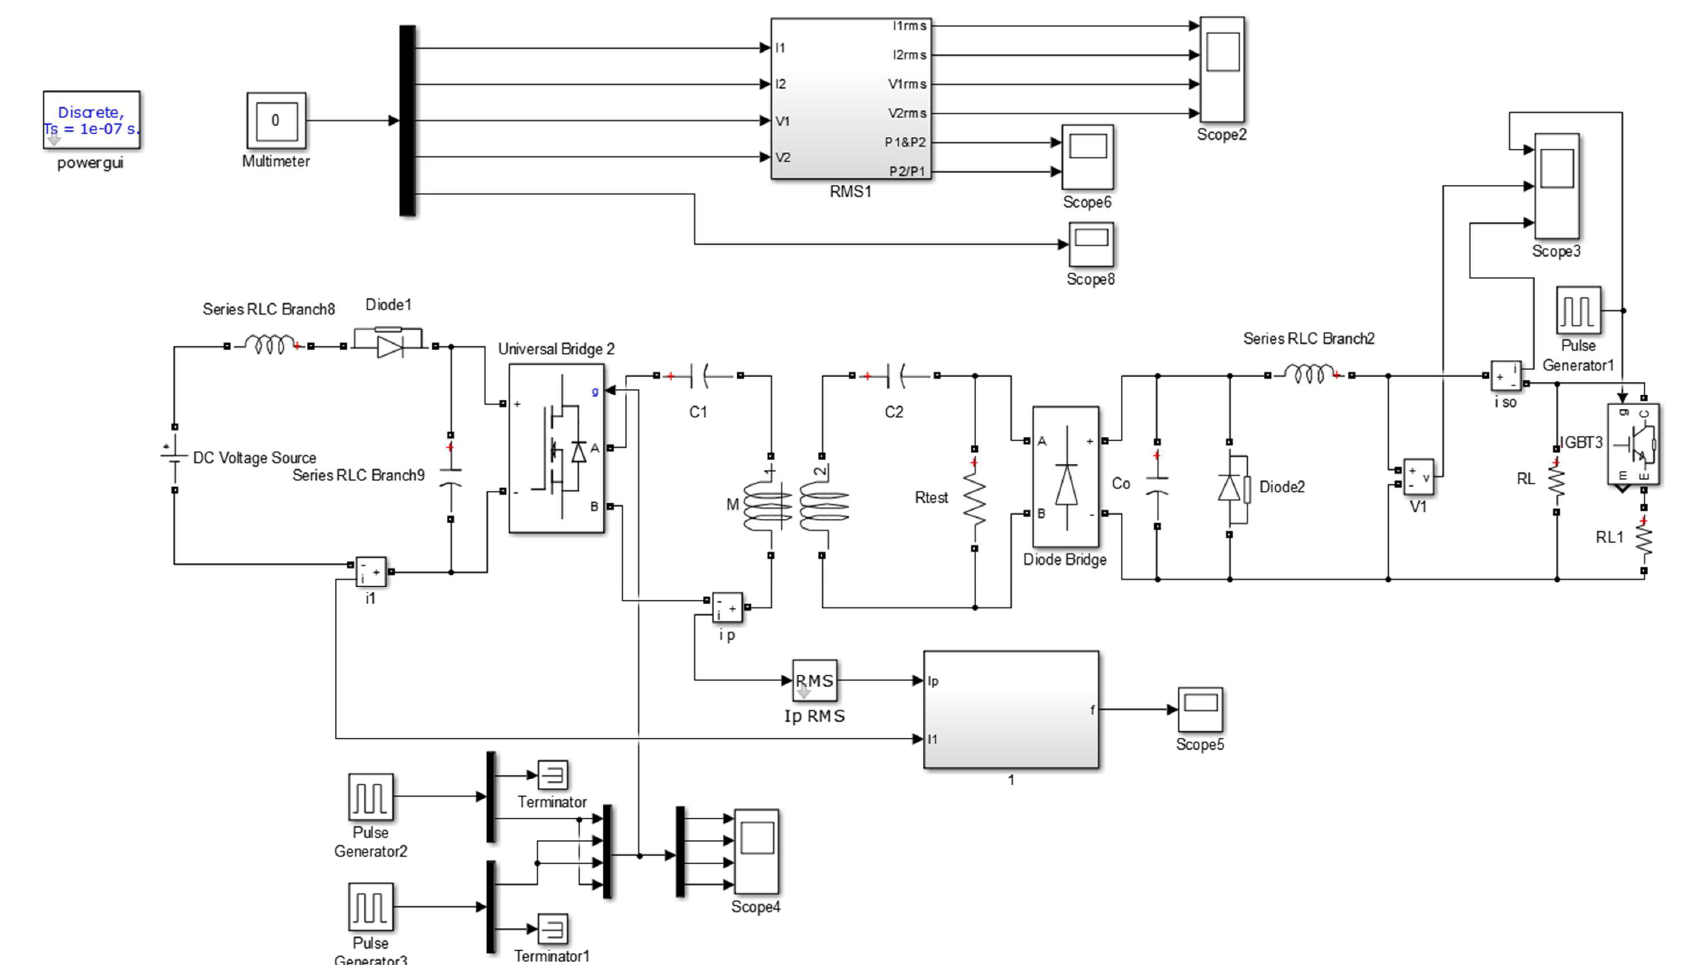
Figure 11. Simulation circuit of frequency adjustment method.